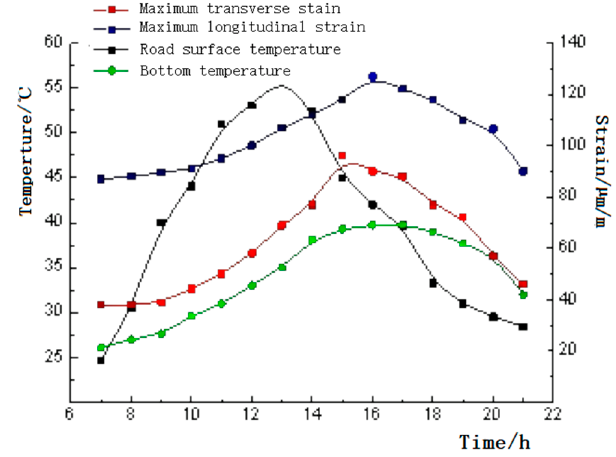
Figure 8. Structure C temperature versus transverse and longitudinal tensile strain at the base of the